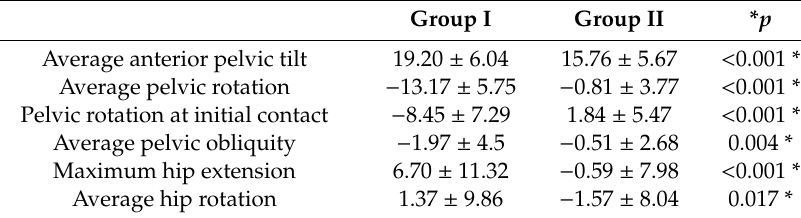
Table 4. Comparisons of kinematic parameters (degrees) between the